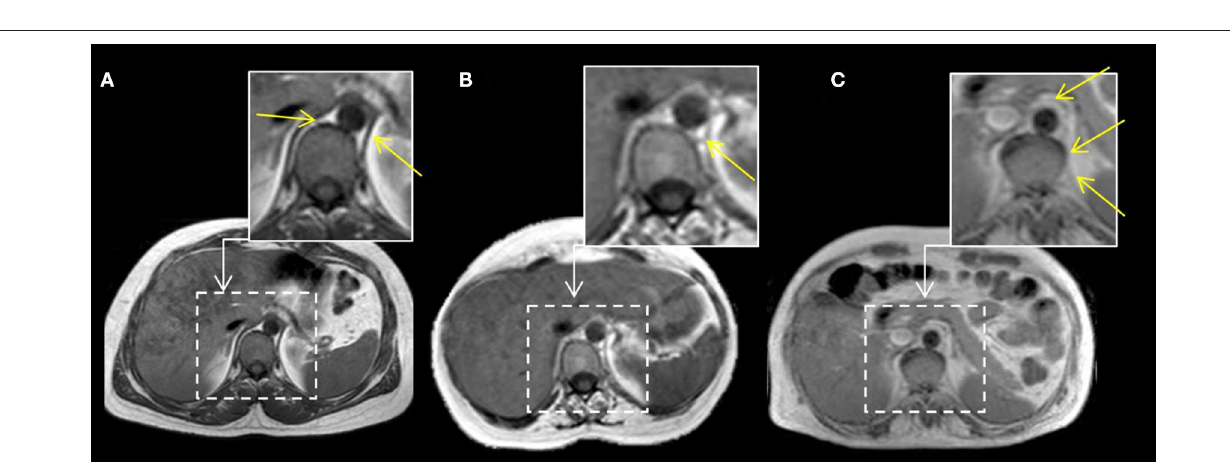
Frontiers in Neurology |